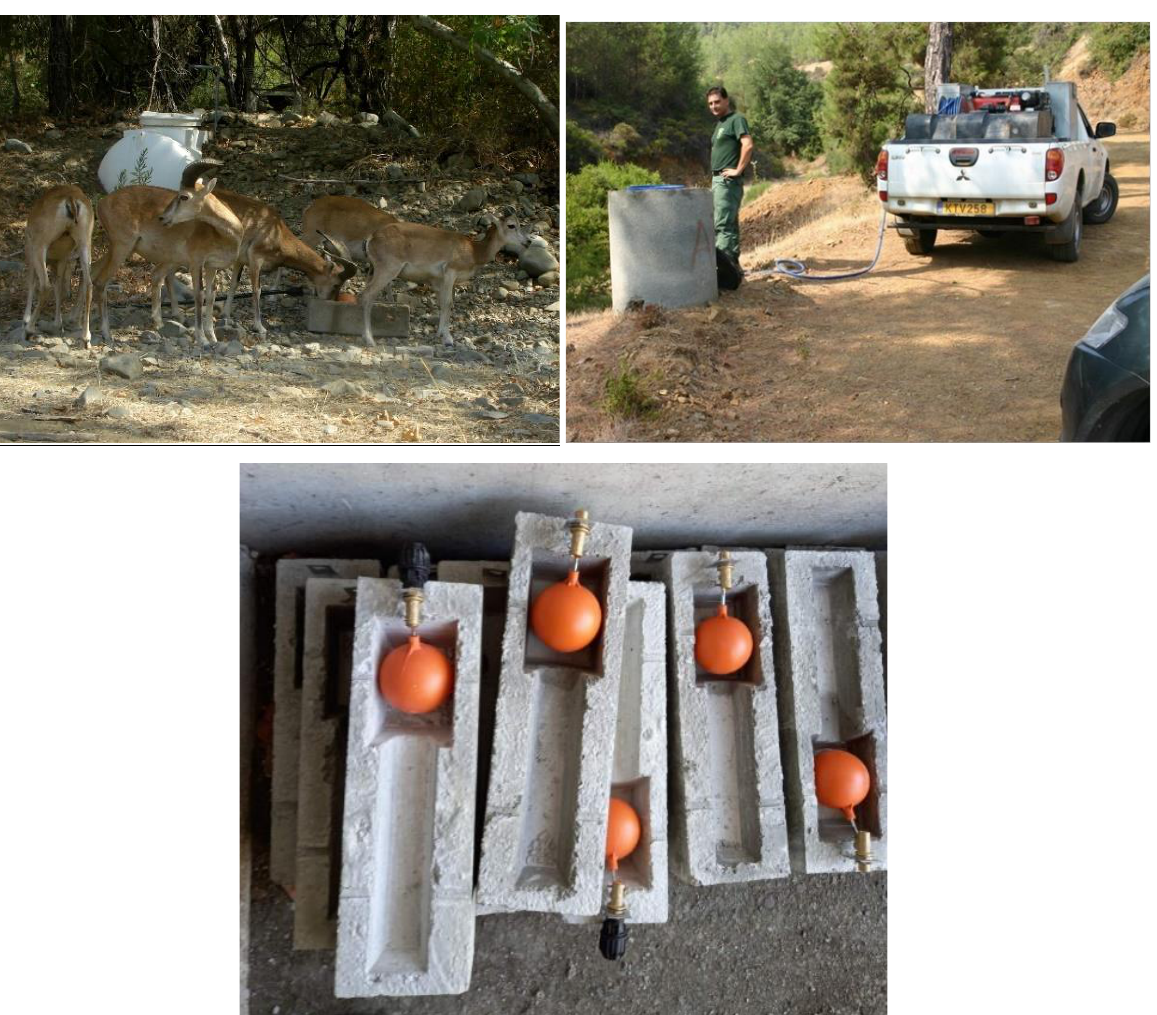
Figure A1. Setup of the water troughs used for the management of water sources of Ovis gmelini ophion (Cyprus mouflon) in Cyprus (photos: © Game and Fauna Service, Ministry of Interior, Cyprus). Each artificial water point consists of a water trough and a water tank. The imple- mented water system uses an air-filled plastic balloon that moves up or down based on